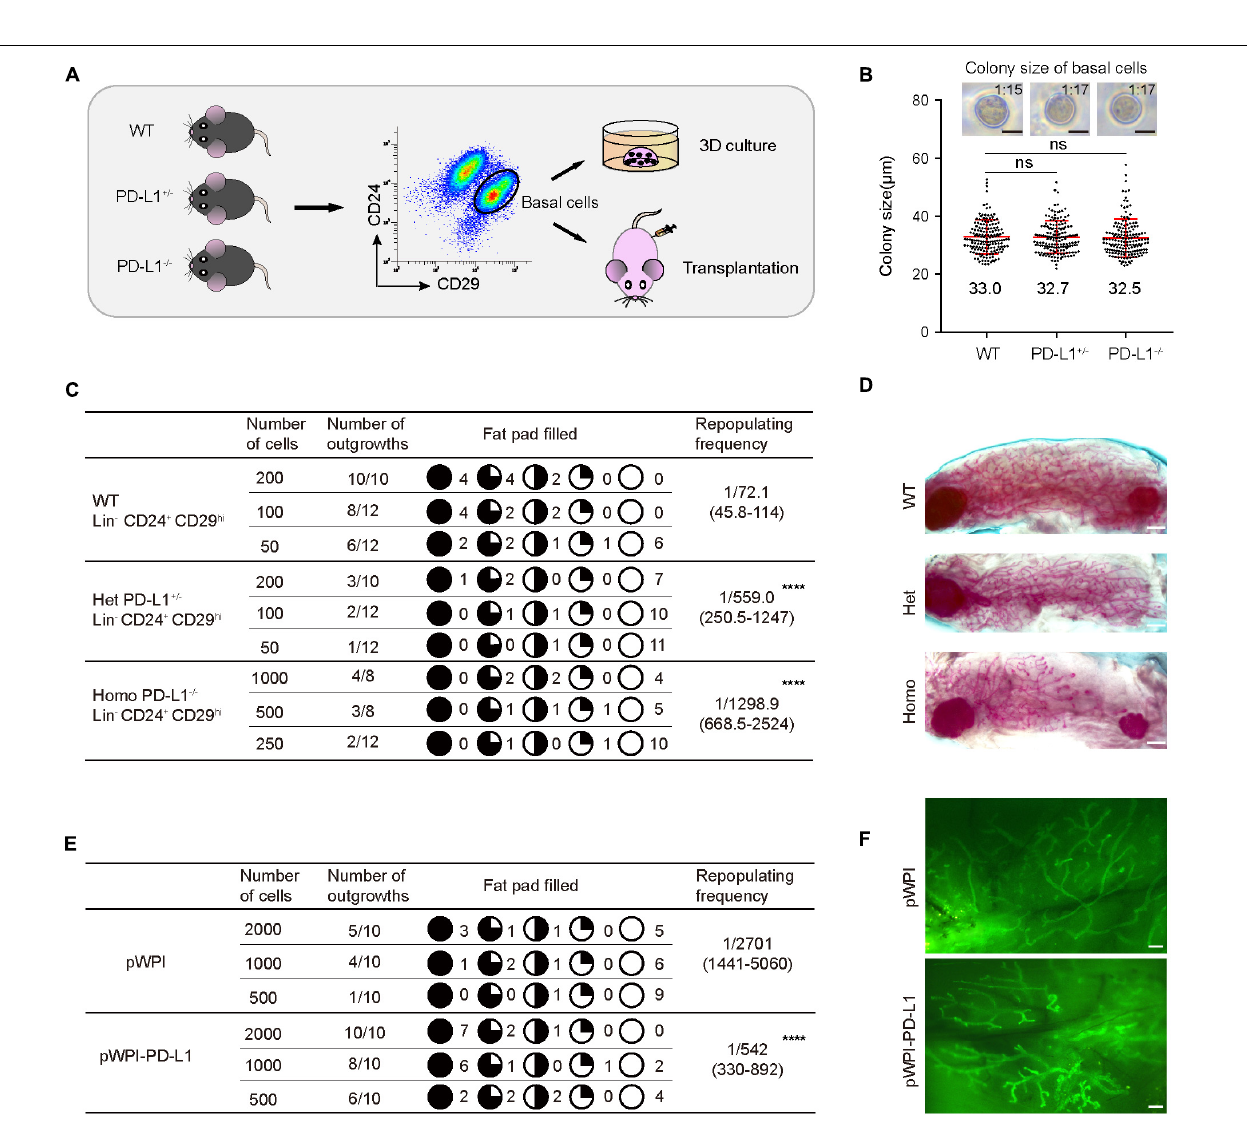
FIGURE 5 | PD-L1 is critical for mammary regeneration in transplantation. (A) Illustration of the 3D culture and transplantation assays. Mammary basal cells were isolated by FACS from WT, PD-L1 + / − or PD-L1 − / − mice for 3D Matrigel culture or transplantation experiments. (B) Colony size of basal cells from WT, PD-L1 + / − , or PD-L1 − / − mice in Matrigel culture. Data are presented as mean ± SD. Scale bars, 50 µ m. (C) Regeneration frequency of WT, PD-L1 + / − , or PD-L1 − / − basal cells. The mammary outgrowth numbers and sizes (shown as the percentage of fat pad filled) are combined from three independent experiments. The mammary reconstitution unit (MRU) frequency is shown for each group. Student’s t -test: **** P < 0.0001. (D) Representative whole-mount images of outgrowths from transplantation of WT, PD-L1 + / − , or PD-L1 − / − basal cells. Scale bars, 1 mm. (E) Regeneration efficiency of pWPI or pWPI-PD-L1 primary mammary cells. The mammary outgrowth numbers and sizes (shown as the percentage of fat pad filled) are combined from three independent experiments. The mammary reconstitution unit (MRU) frequency is shown for each group. Student’s t -test: **** P < 0.0001. (F) Representative whole-mount images of outgrowths from transplantation of pWPI or pWPI-PD-L1 primary mammary cells. Scale bars, 0.5 mm. FACS, fluorescence-activated cell sorting; PD-L1, programmed cell death ligand